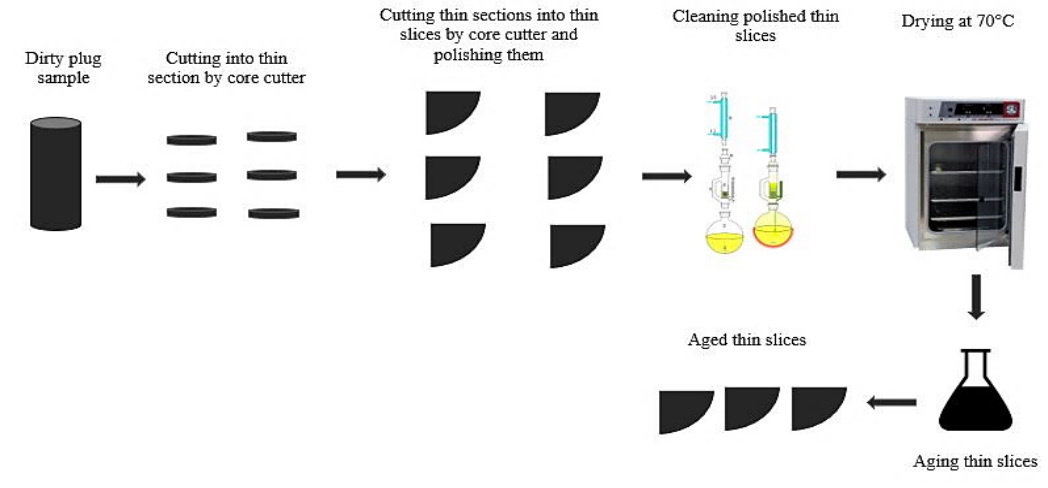
Figure 2. A schematic of the thin section rock aging setup and the workflow used for preparation of rock samples for contact angle measurement.